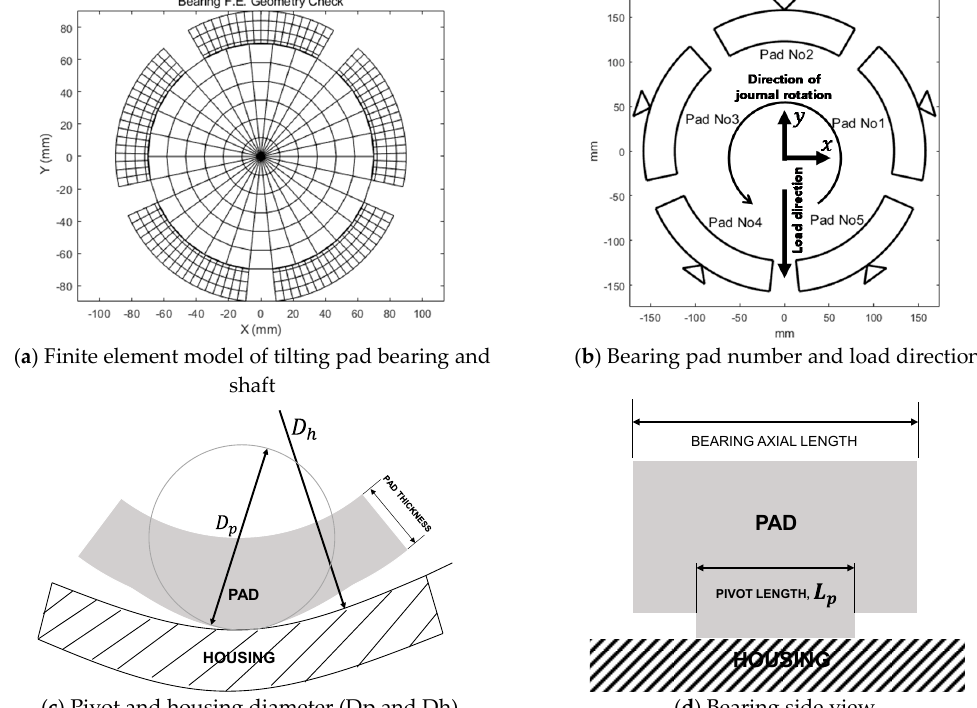
Figure 4. Tilting pad journal bearing configuration with cylindrical pivot.